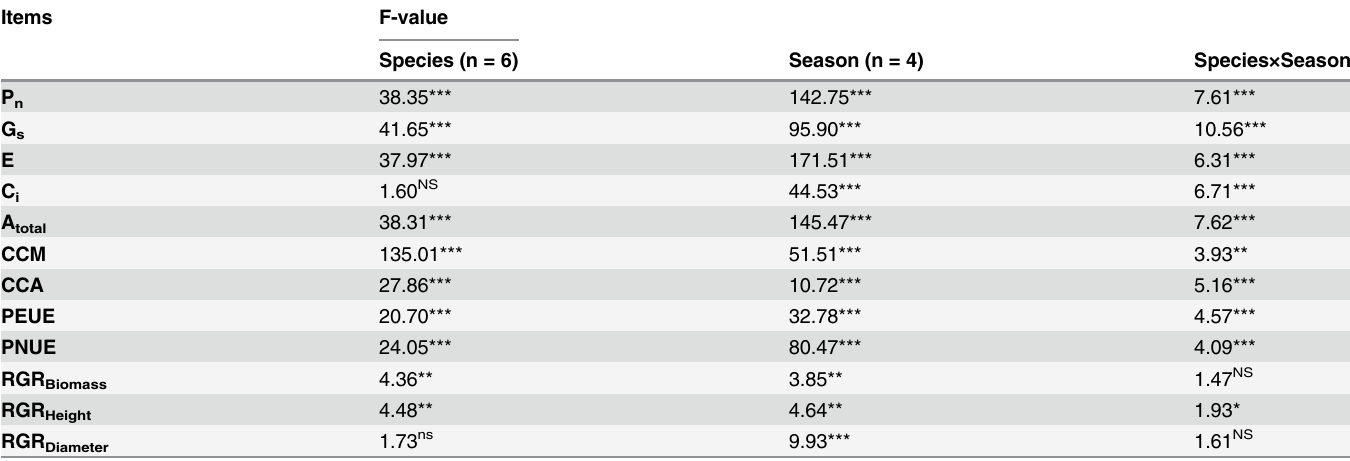
Table 2. F values of the two-way ANOVA test showing the effects of species and seasons and their interactions on the photosynthetic characteris- tics, energetic cost and growth traits of mangrove plants. Items